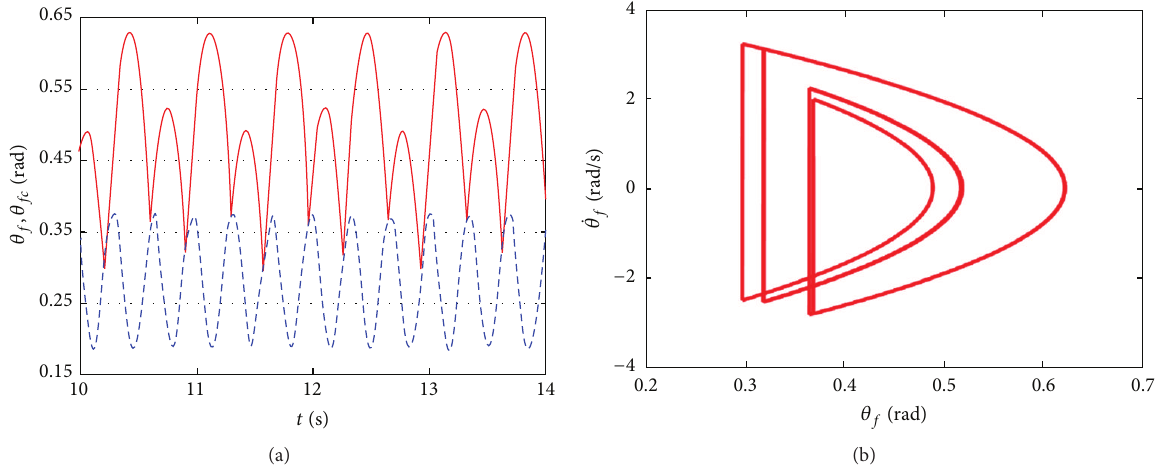
Figure 7: 𝑃(4, 4) motion when 𝜔 = 18.5 rad/s: (a) time history of 𝜃 𝑓 (solid line) and 𝜃 𝑓𝑐 (dashed line) and (b) phase